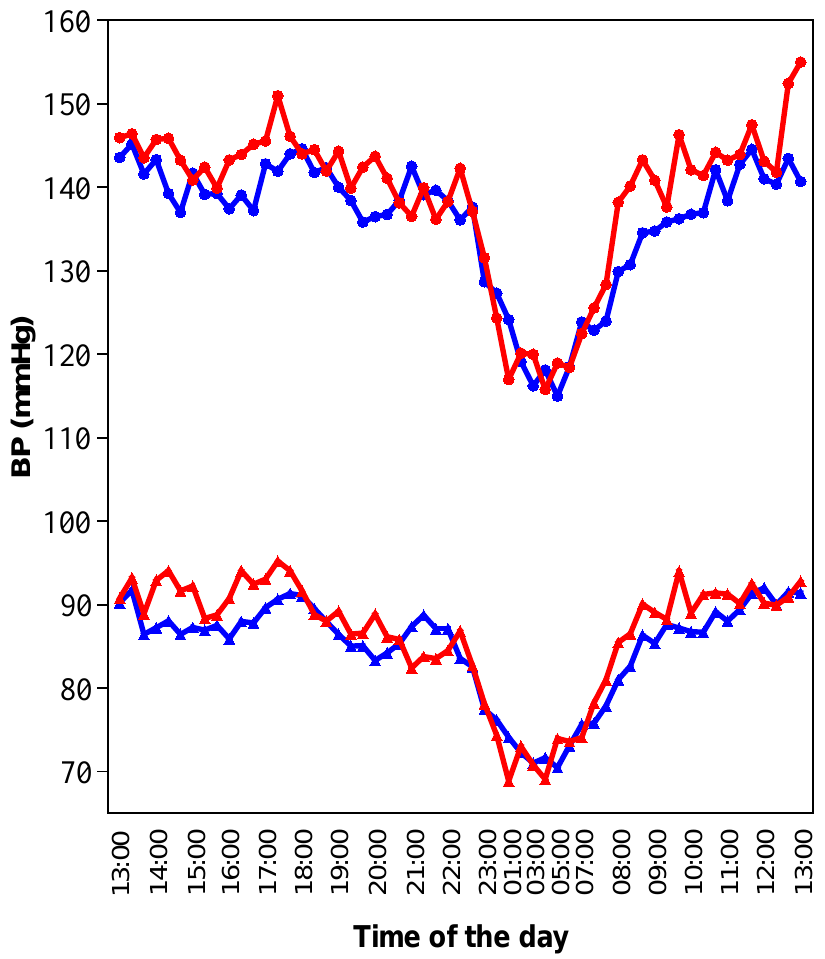
Figure 1. Twenty-four-hour ambulatory recordings of SBP and DBP. This data was extracted from intervention group 1 where placebo was compared with the grape-wine extract. Mean data per time point from 30 subjects is presented. The red line represents placebo and the blue line the grape-wine extract. Circles represent SBP and triangles DBP. Time zero started at 1:00 p.m. and ended at 1:00 p.m. on the following day. Compared to placebo, SBP and DBP were lower during the daytime with the grape-wine extract, but the extract did not affect the nighttime BP